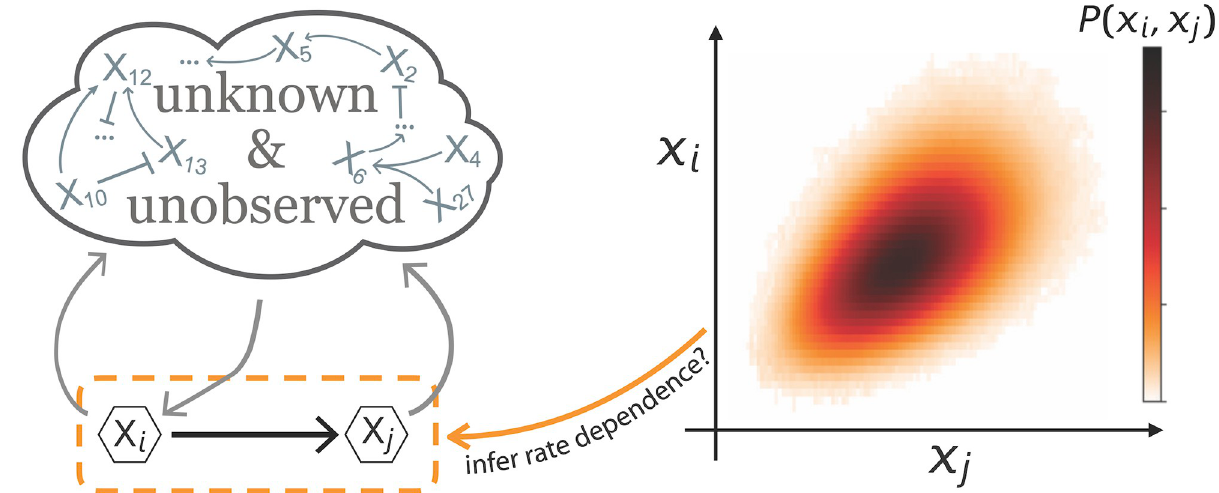
Fig 1. Our goal: Determining how one component affects the production rate of another from observing their joint probability distribution in a sea of unobserved components with unknown dynamics. The joint probability distribution between two components P ( x i , x j ) varies enormously between systems even for identical regulation of X i through X j . However, previous work has shown that all systems with a given interaction between the two components satisfy invariant probability flux balance relations [18]. Here, we demonstrate that such relations can translate qualitative local network knowledge into quantitative rate functions using only the observed joint probability distributions between X i and X j even when the dynamics within the rest of the network is unobserved and completely unknown.